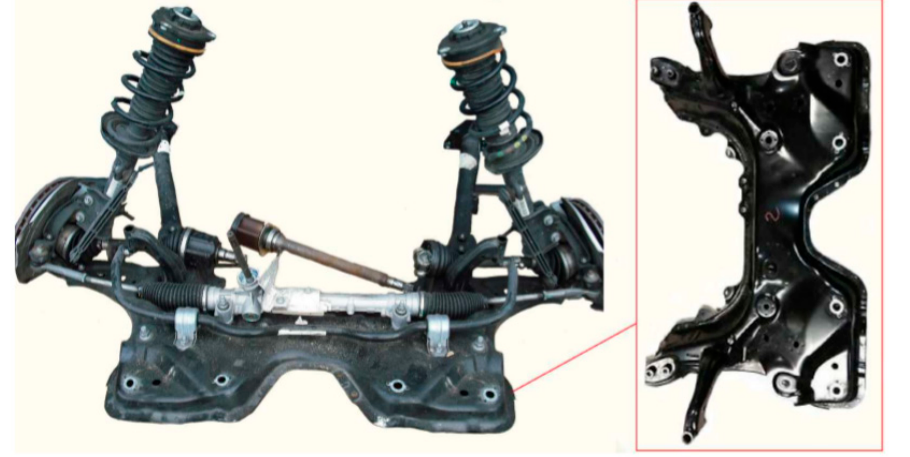
Figure 1. Upper cross member B-Suv.